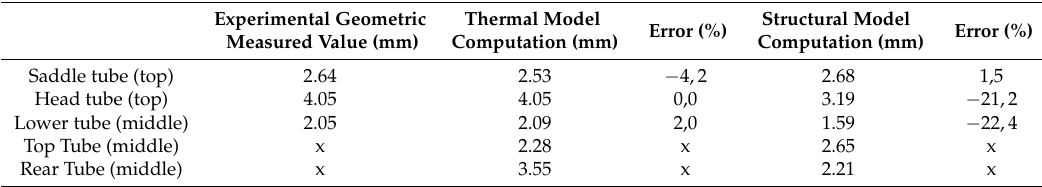
Figure 9. Thermal response of the crack after PCT (Bin 4). Table 4. Optimization